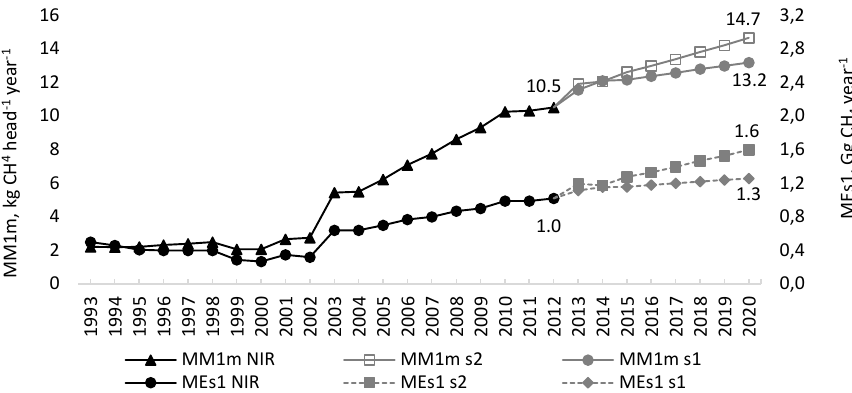
Fig. 6. Actual and projected EF of CH year -1 ) from manure management in 1993 − 2020 (projections of the Estonian agricultural model, Estonian NIR 2014, Estonian CRF